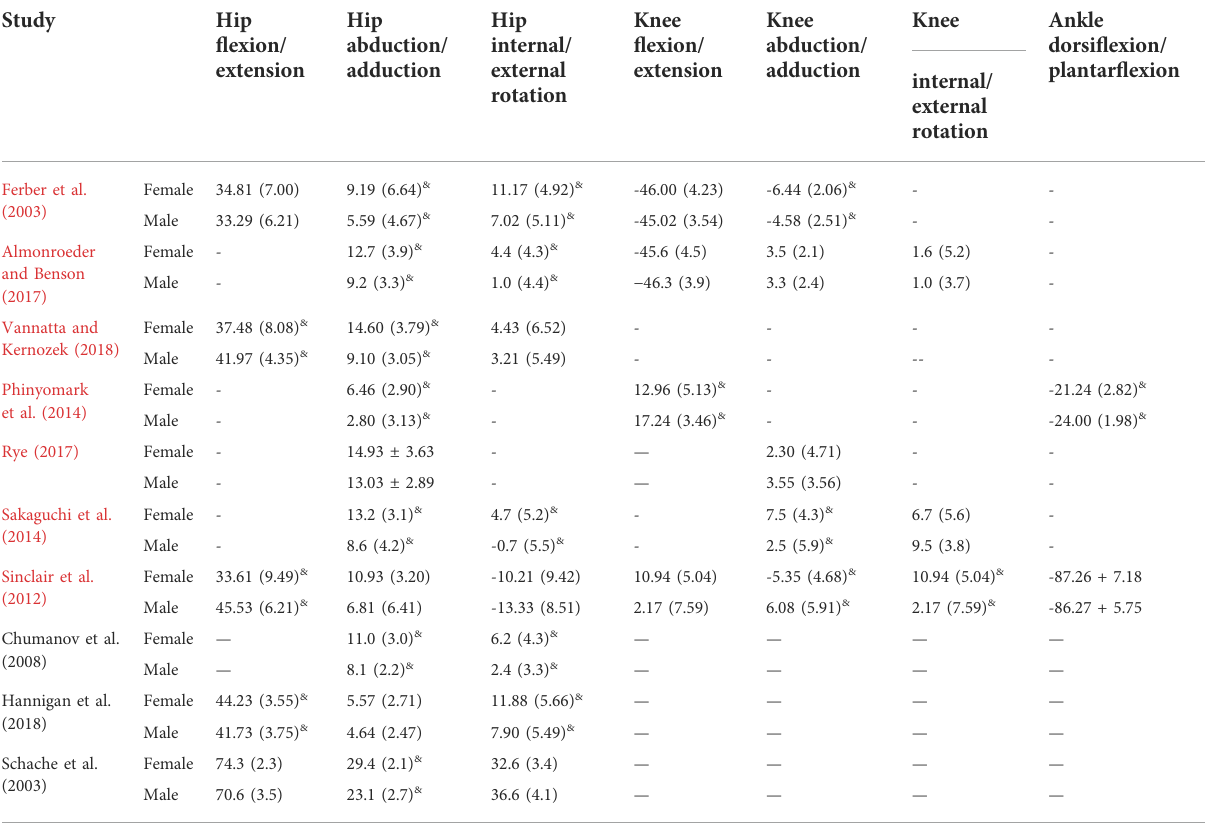
TABLE 3 Kinematic parameters of included studies ( “ & ” represents signi fi cant difference in included